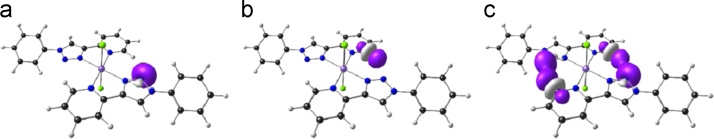
B3LYP optimized geometry of dichloro{bis[2-(1-phenyl-1H-1,2,3-triazol-4-yl-κN3]pyridine-κN]}iron(II), [FeII(L8)2Cl2], showing (a) a LP(N) NBO, (b) a BD*(C-H) NBO and (c) the two LP(N) -> BD*(C-H) natural bonding orbital interactions of 0.75 kJ/mol each. Colour code of atoms (online version): Fe (purple), Cl (green), N (blue), C (black), H (white).